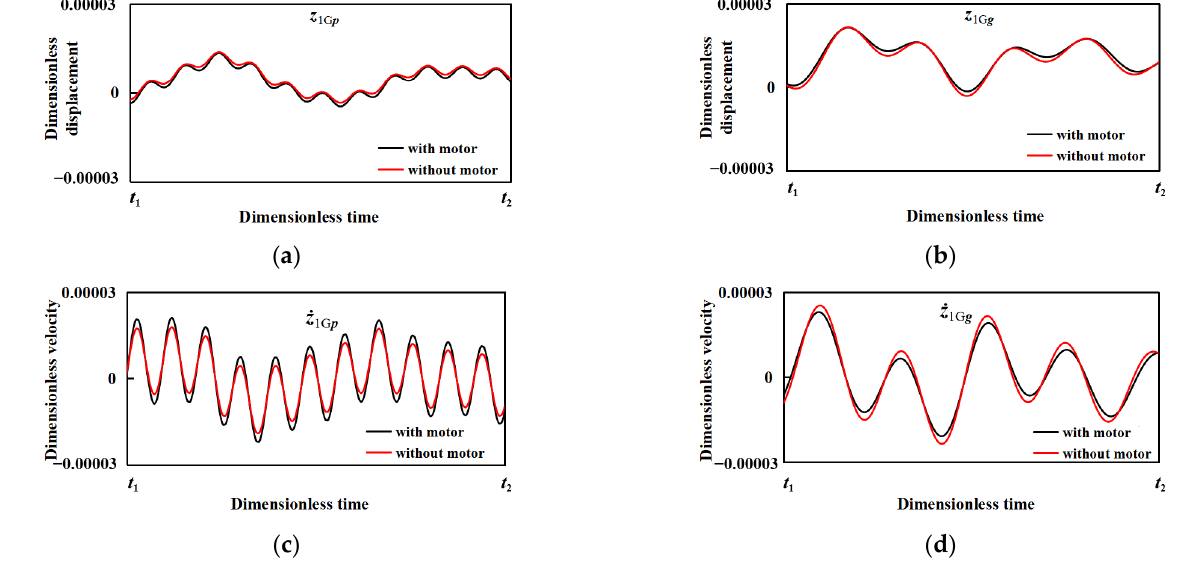
Figure 14. Comparison of the first-stage gear pair vibration curves with and without motor excitation: ( a ) gear Z 1 vibration displacement curves; ( b ) gear Z 2 vibration displacement curves; ( c ) gear Z 1 vibration velocity curves; ( d ) gear Z 2 vibration velocity curves.